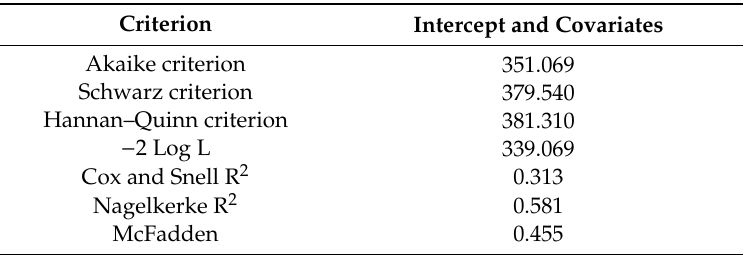
Table 5. Association of predicted probabilities and observed responses.